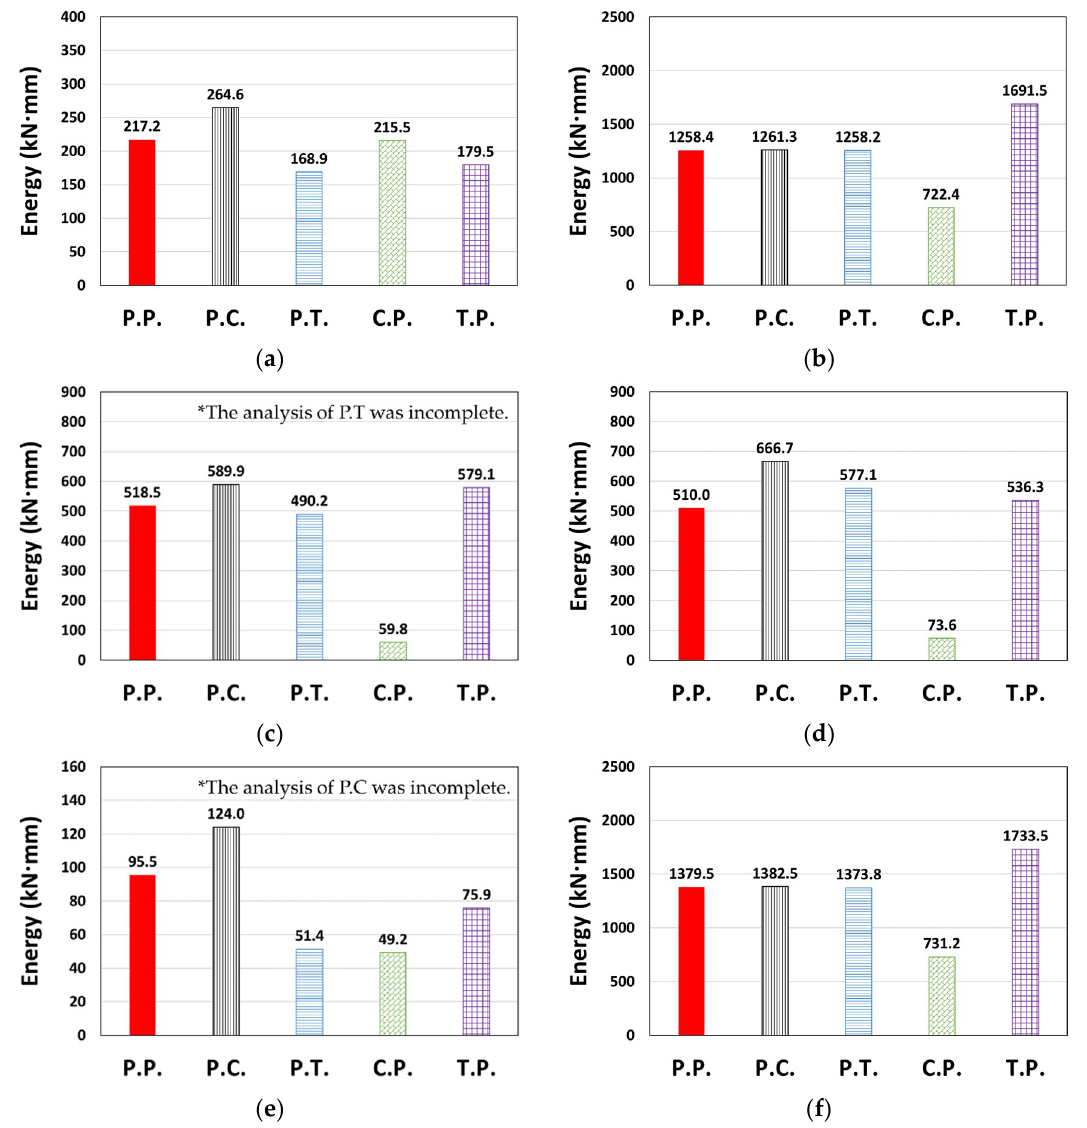
Figure 17. Total dissipated energy ( E t ): ( a ) Type 1 (Northridge, X-dir.), ( b ) Type 1 (Northridge, Y-dir.), ( c ) Type 2 (El Centro, X-dir.), ( d ) Type 2 (Northridge, Y-dir.), ( e ) Type 3 (Northridge, X-dir.), and ( f ) Type 3 (Northridge, Y-dir.).